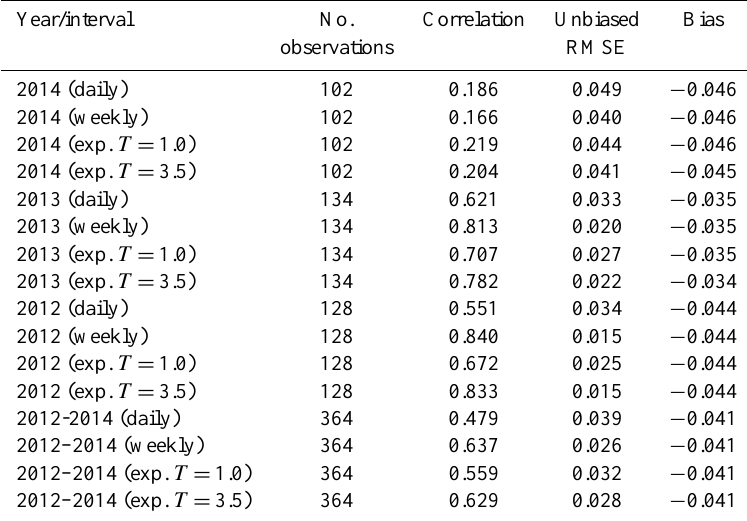
Table 3. Top soil layer ESA CCI soil moisture data product estimate comparison metrics/year against weighted areal average in situ obser- vations.